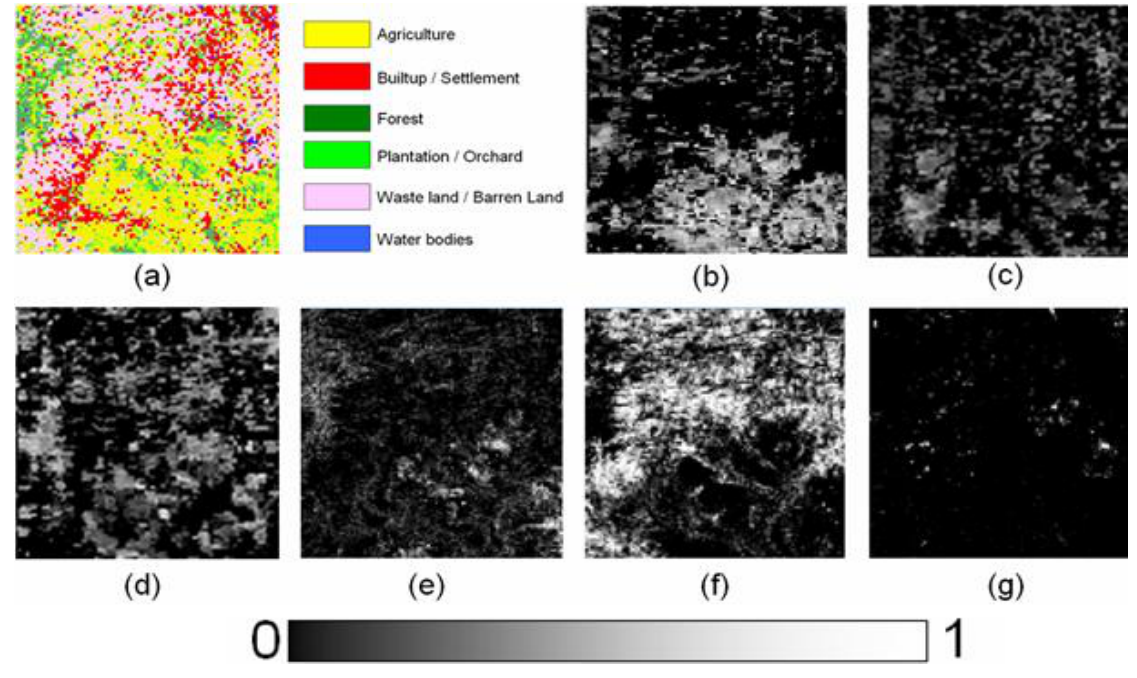
Figure 10. ( a ) LISS-III classified map resampled to 100 × 100 pixels. Abundance maps for ( b ) agriculture; ( c ) built-up/settlement; ( d ) forest; ( e ) plantation/orchard; ( f ) wasteland; ( g ) water bodies obtained from